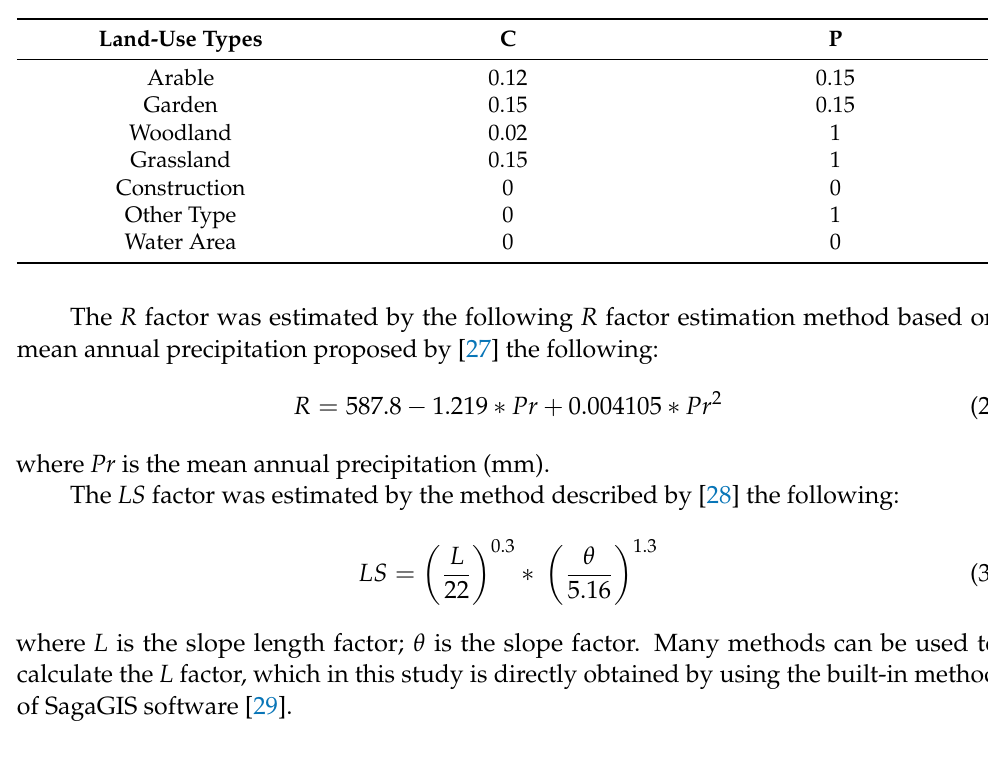
Table 2. C and P factor of different land-use